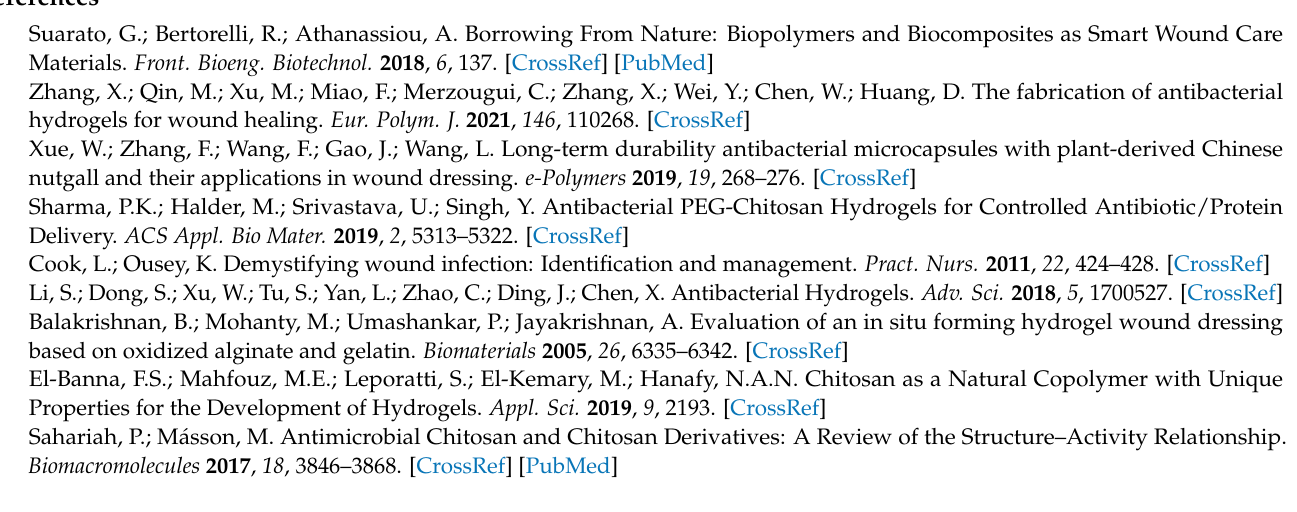
trations, Figure S2: Bacterial growth inhibition zone at different concentrations, Table S1: Element analysis results of CTS-CHO, Table S2: Inhibitory zone of CTS-CHO at different